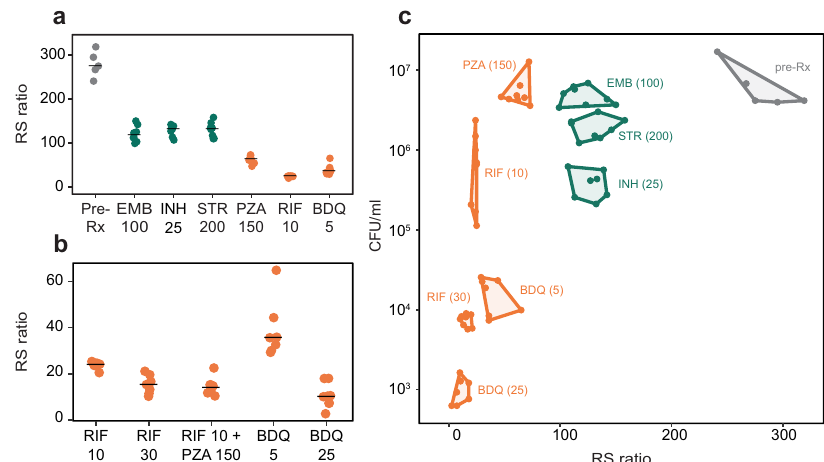
Fig. 4 Canonical sterilizing drugs suppress rRNA synthesis more than non-sterilizing drugs in mice. a RS ratio in lung tissue of BALB/c mice treated for 28 days with individual non-sterilizing (green) and sterilizing (orange) drugs. Dots indicate individual mice ( N = 8 per treatment). Horizontal lines indicate group means. b Dose – response relationship between rifampin and bedaquiline dose and the RS ratio. Also shown is the combination of rifampin 10 mg kg − 1 and pyrazinamide. Dots indicate individual mice ( N = 8 per treatment). Horizontal lines indicate group means. c Contrasting effects of 28-day treatment with individual drugs/doses on CFU and the RS ratio in BALB/c mice. A convex hull was used to display data groupings. Source data are provided as a Source Data fi population did not expand suf fi ciently to have a substantial